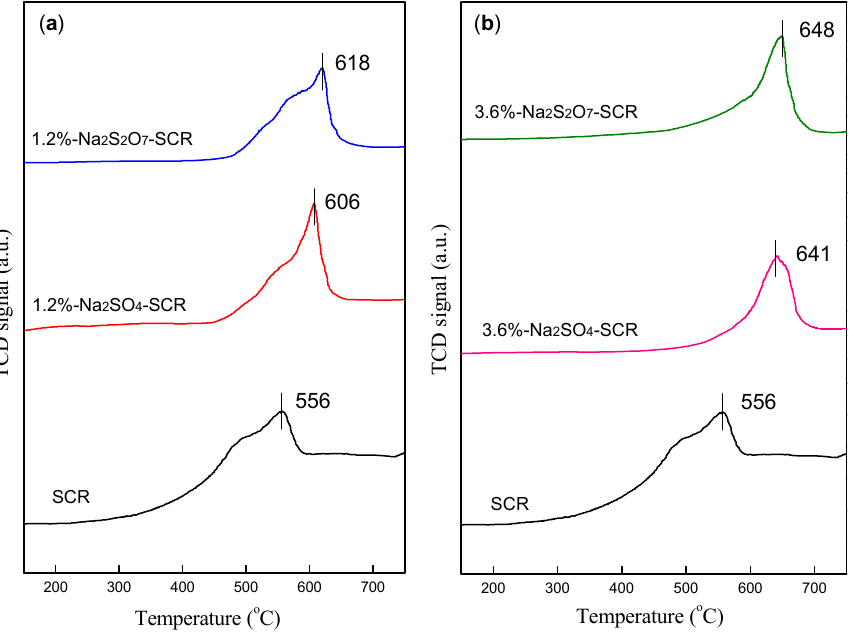
Figure 7. H 2 -TPR profiles of the catalyst samples for Na content ( a ) 1.2% and ( b ) 3.6%.